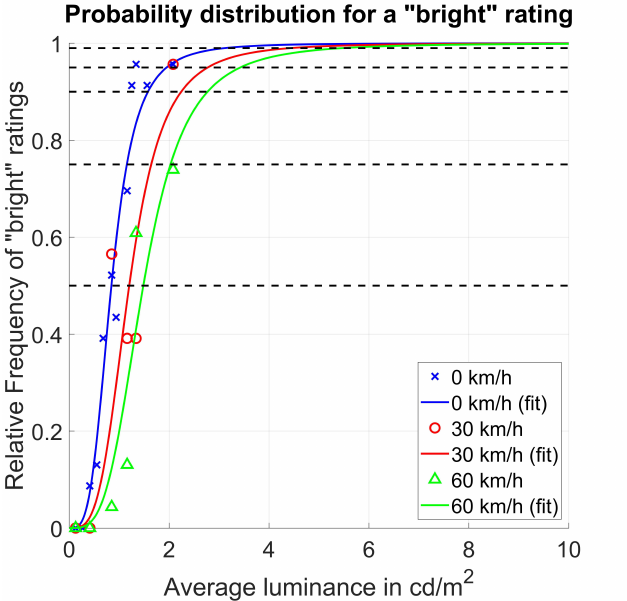
Figure 8. Relative frequency of “bright” or better responses at different driving speeds as fitted by the psychometric model of Equation (4). The probability of a “bright” or better rating increases with increasing roadway luminance. At higher speeds, a higher roadway luminance must be available to keep this probability at the same